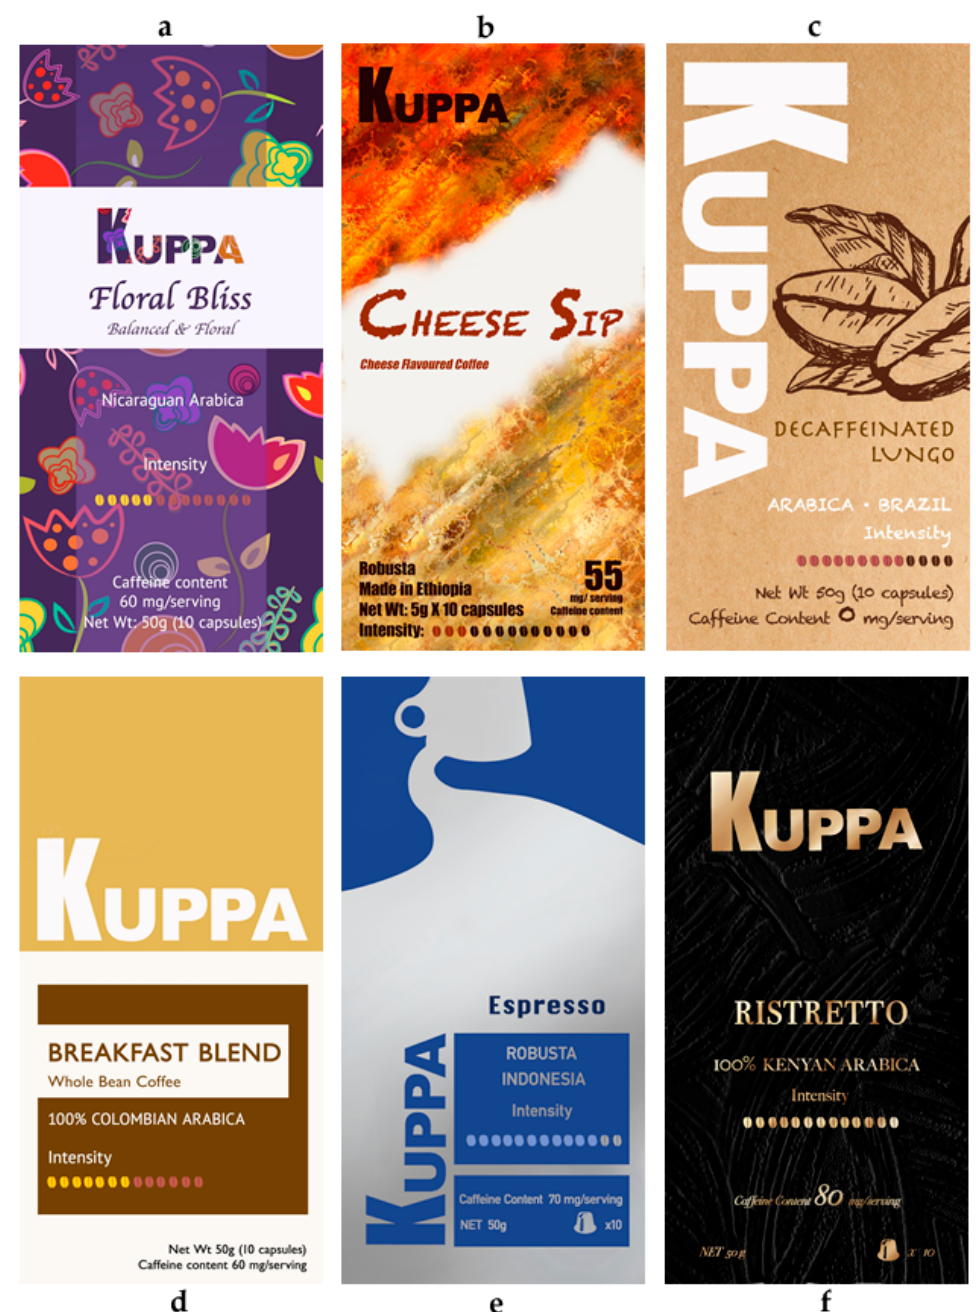
Figure 1. Labels developed based on the TNS Needscope model ™ for the six segments: ( a ) fun, ( b ) bold, ( c ) natural, ( d ) everyday, ( e ) classic, and ( f ) premium. ( b ) bold, ( c ) natural, ( d ) everyday, ( e ) classic, and ( f )